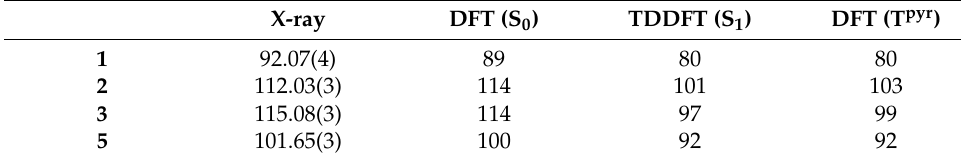
Figure 5. Natural transition orbitals HONTO ( a ) and LUNTO ( b ) for the S 0 → S 1 excitation of 2 as an isosurface at 0.05 a.u. Table 4. P–M–P angles in X-ray and DFT